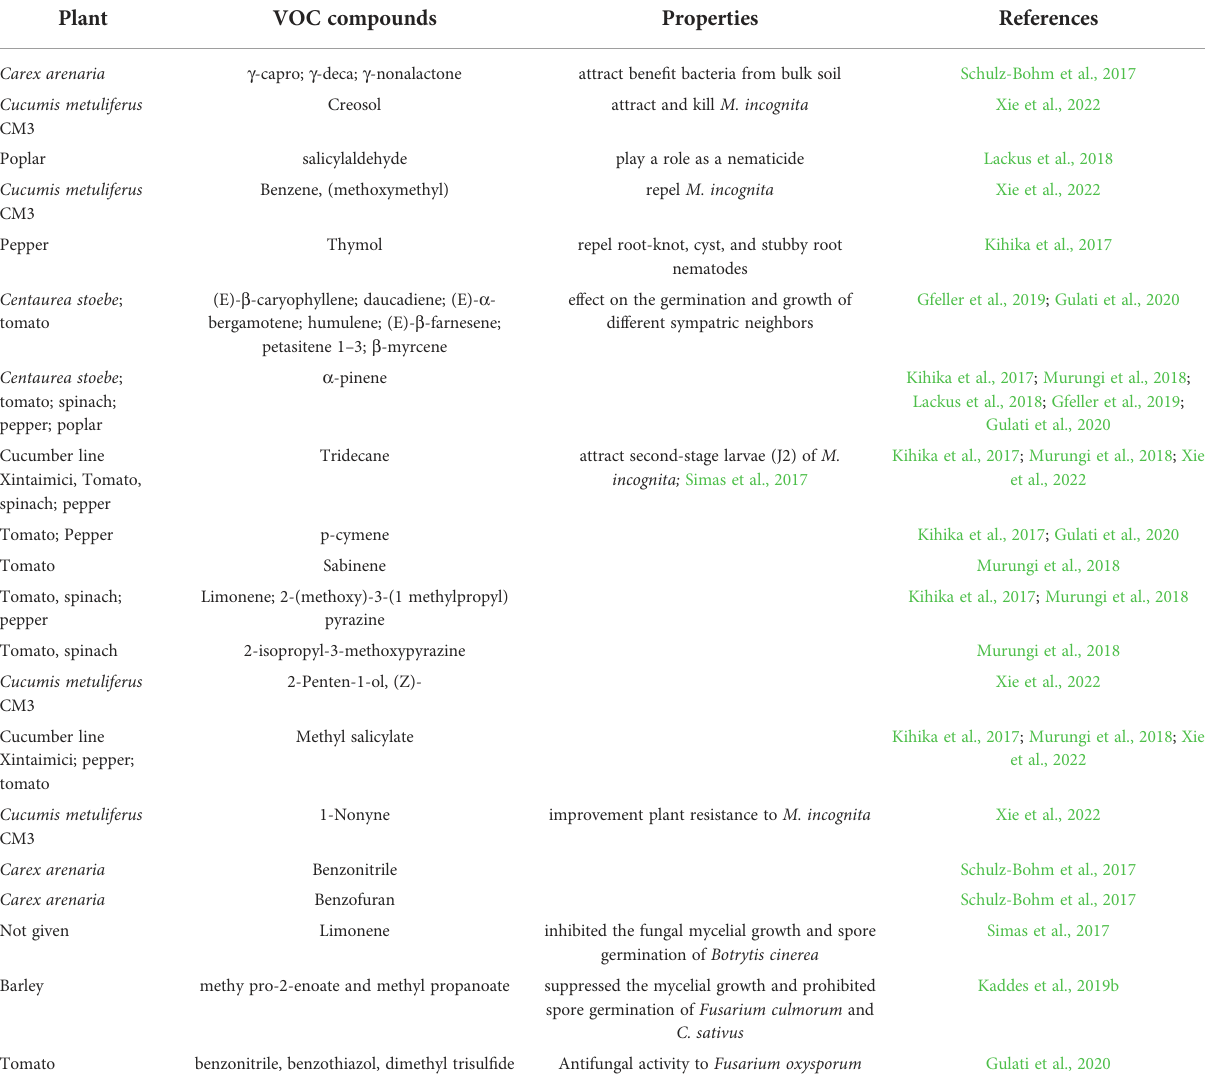
TABLE 1 Plant root VOCs and its